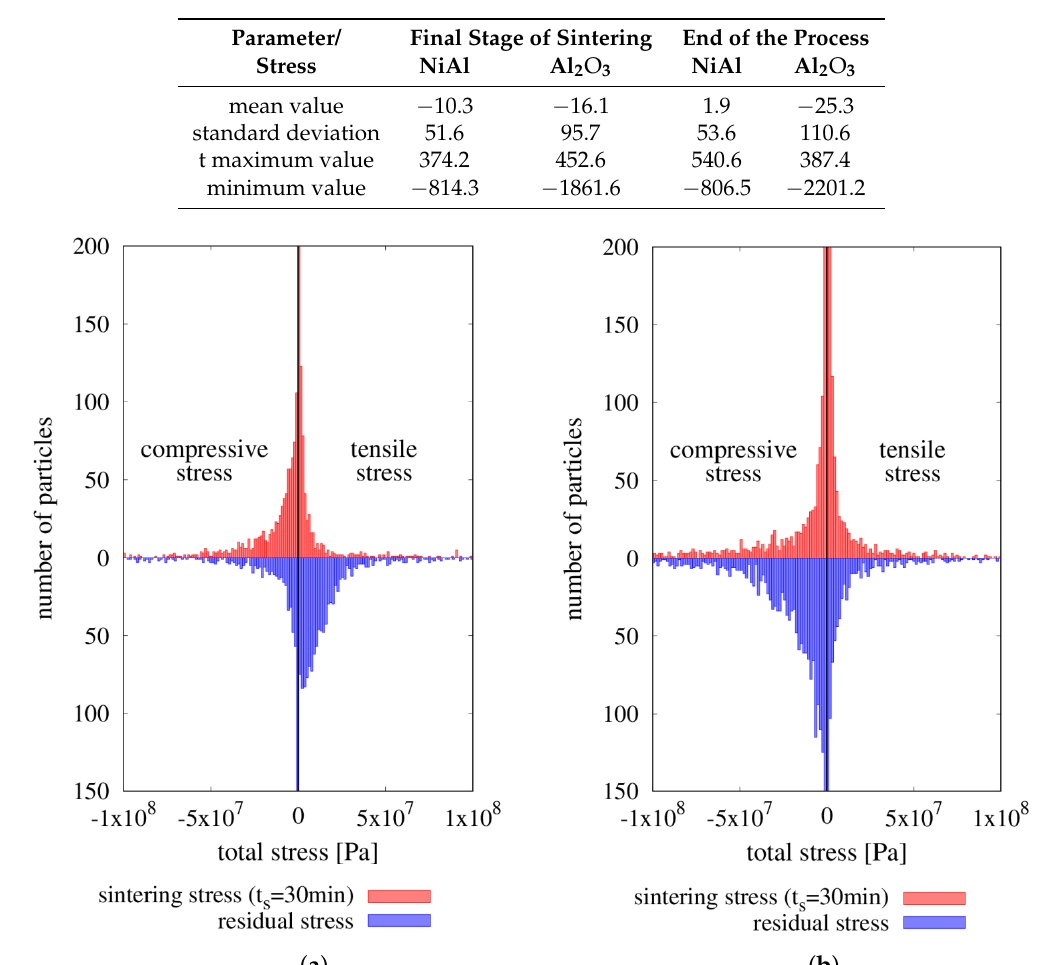
Figure 16. The histograms of particle total hydrostatic stresses in the final stage of sintering and at the end of the process (after cooling) of ( a ) NiAl and ( b ) alumina